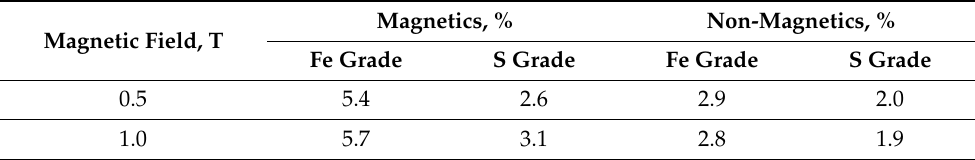
Table 2. Result of high-gradient magnetic